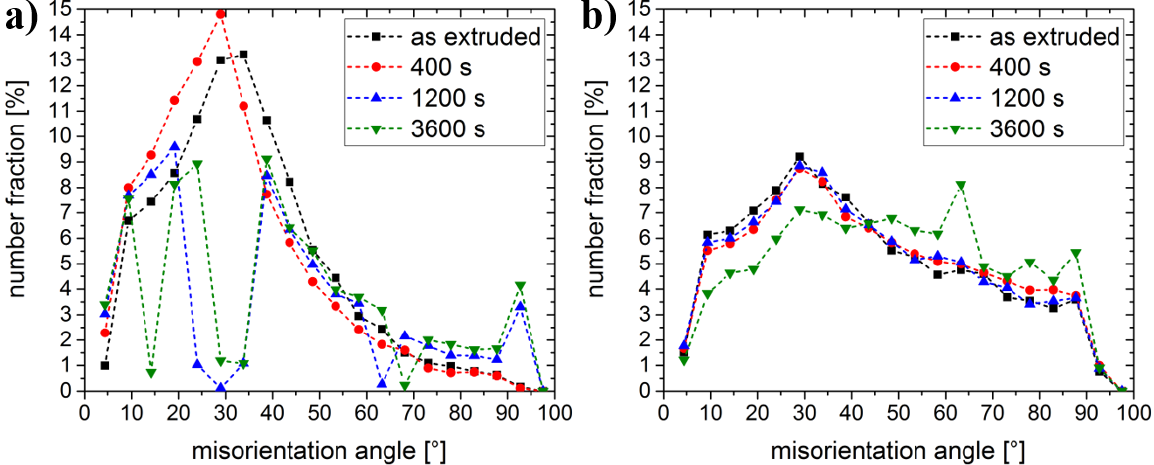
Figure 10. Development of misorientation distribution with increasing dwell time: ( a ) reference area, and ( b ) weld seam area.